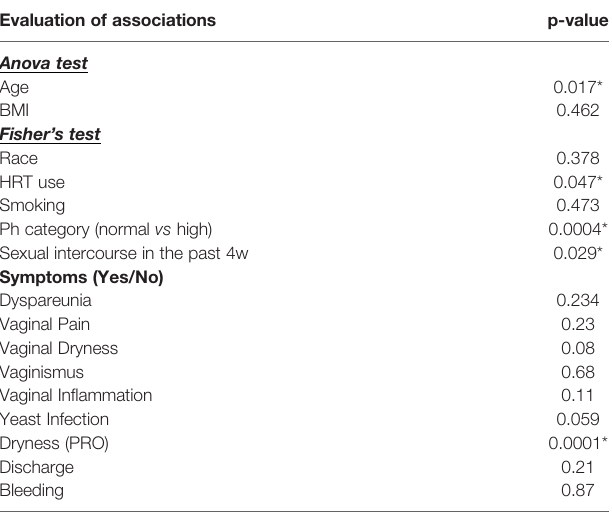
TABLE 3 | Associations of vaginal symptoms and clinical data with identi fi ed vaginal community state types in cancer and healthy postmenopausal